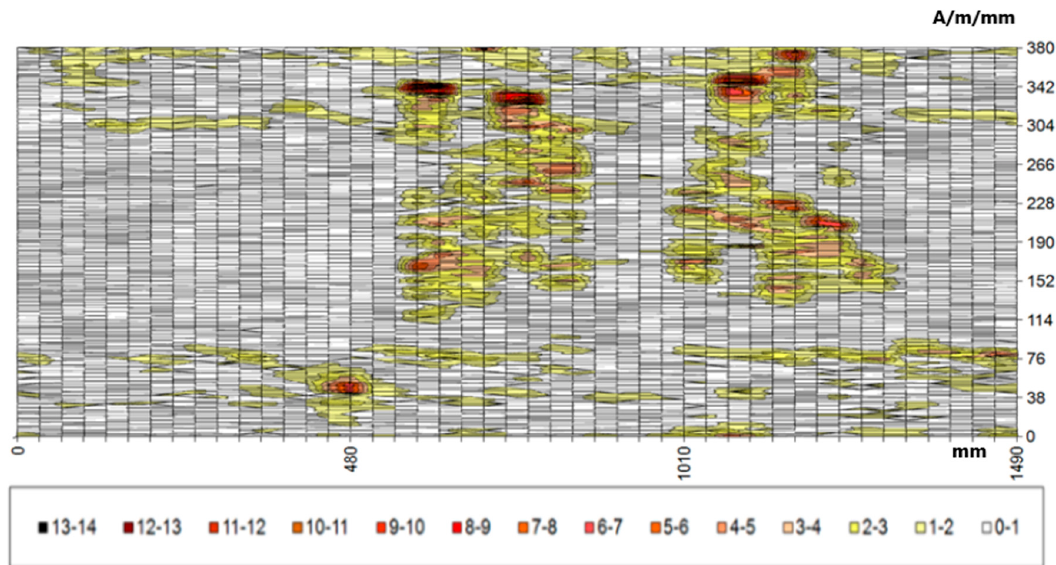
Figure 9. Distribution of the gradient of the normal component for the selected area.